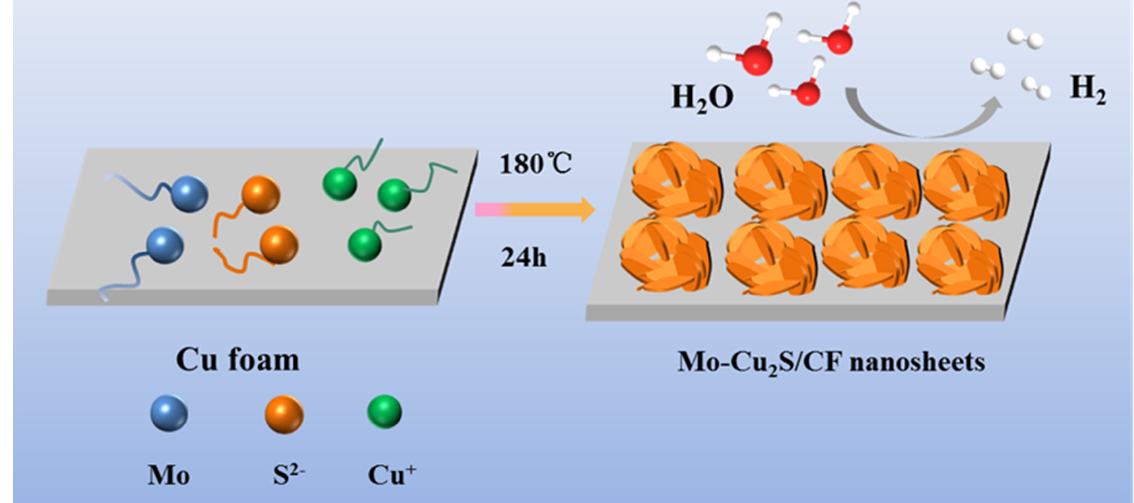
Figure 1. Schematic illustration of the construction of Mo-Cu2S/CF.